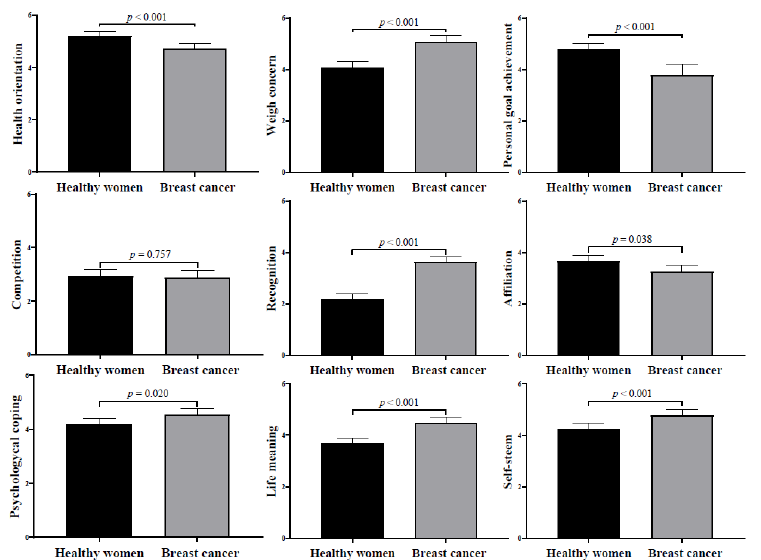
Figure 1. Differences for each of the MOMS dimensions in healthy runners and runners with breast cancer. Note. The reported β values are standardized coefficients. Covariates included were age and body mass index (kg/m 2 ).